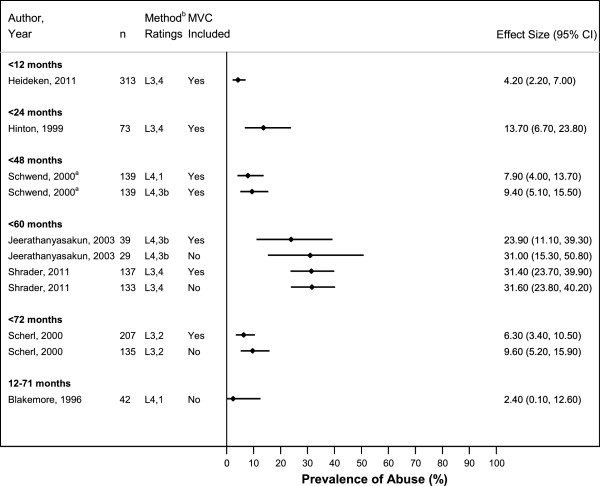
Probability of Abuse in Children with Diaphyseal Femur Fractures. aStudy was limited to children with isolated femur fractures without additional injuries. bPresents overall study methodology ranking (L1-L5) and abuse determination methodology ranking (1–5).